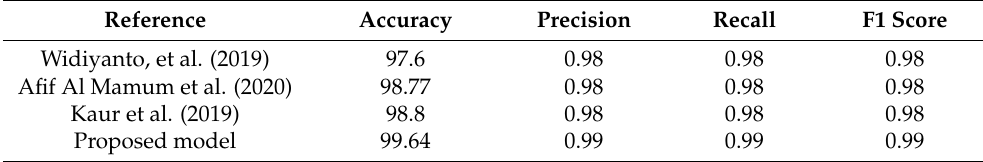
Table 5. Class-wise Performance of the Proposed